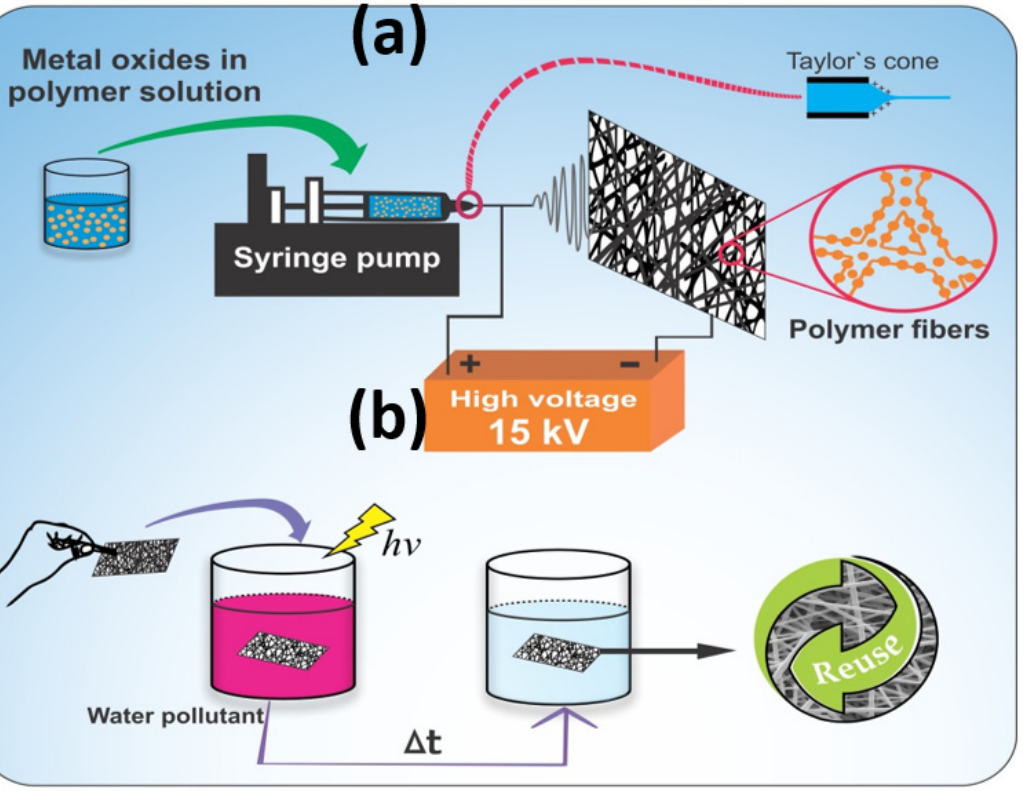
Figure 1. Illustrative scheme of the ( a ) MON dispersed in electrospun fibers and their use in ( b ) photodegradation of the dye in aqueous solution. ( b ) photodegradation of the dye in aqueous